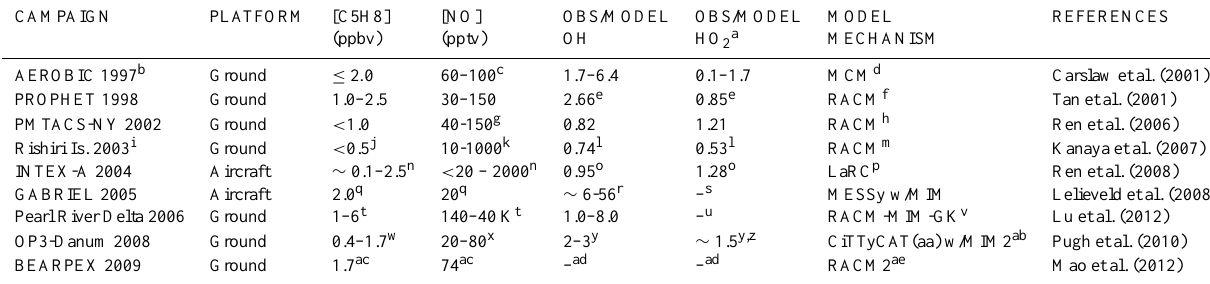
Table 1. Published field campaigns incorporating HO x measurements in or above forest environments.